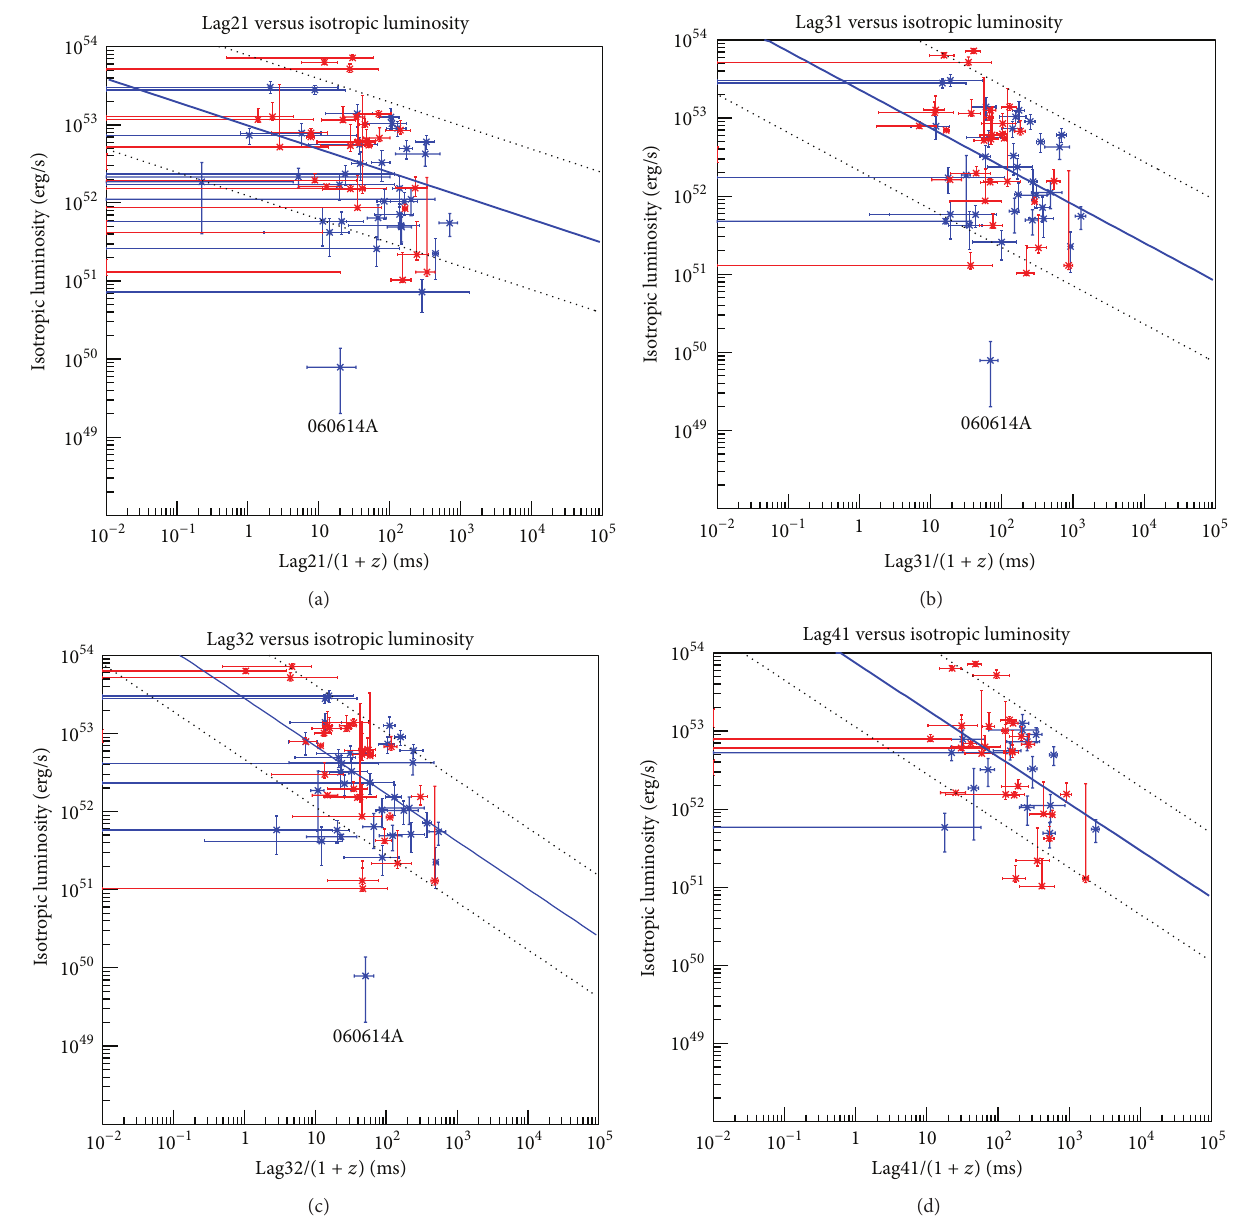
Figure 2: The lag versus isotropic peak luminosity. The blue points are our results. The red points are the results which are reported in Ukwatta et al. 2010. The blue lines are best fit values of power-law fitting. The black dotted lines show the region corresponding to variance 𝜎 𝐿 iso . (a) Between 25–50 keV and 15–25 keV, (b) between 50–100 keV and 15–25 keV, (c) between 50–100 keV and 25–50 keV, and (d) between 100–200 keV and 15–25